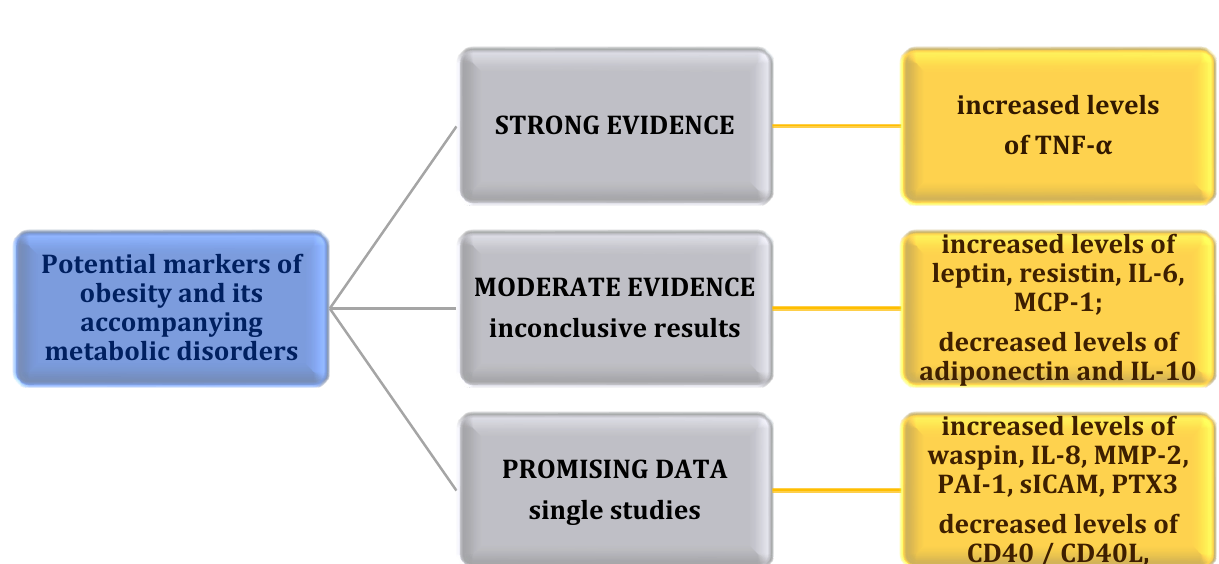
Figure 1. Potential markers of obesity and its accompanying metabolic disorders.